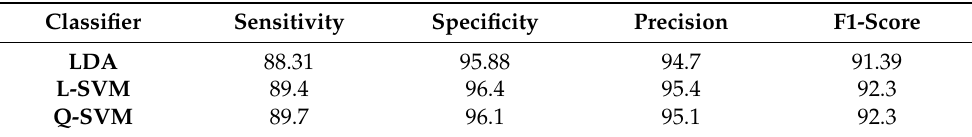
Table 7. The Performance Metrics (%) for the spatial-spectral features of ResNet50+Inception+ InceptionResNet integrated using DWT.